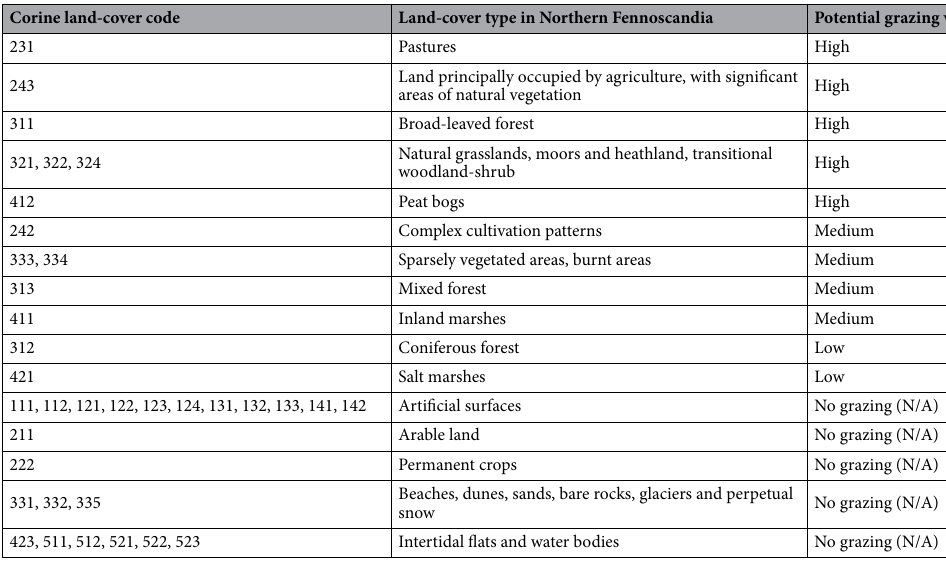
Table 1. Reclassification table of the Corine land-cover types in degree of usage by the grazers in summer according to expert knowledge and literature 22,32,50